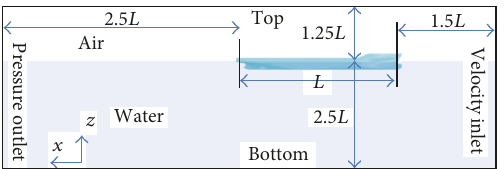
Figure 2: Computational domain for flow field simulations of KCS.